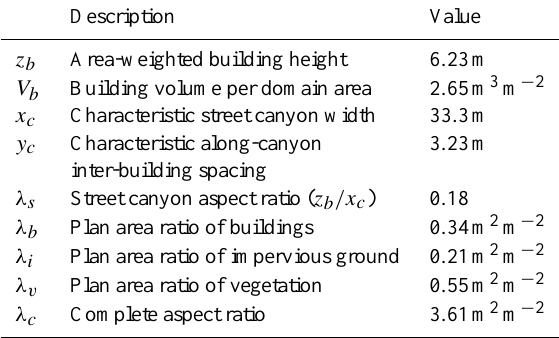
Table 2. Morphometric parameters describing the simulated urban domain.